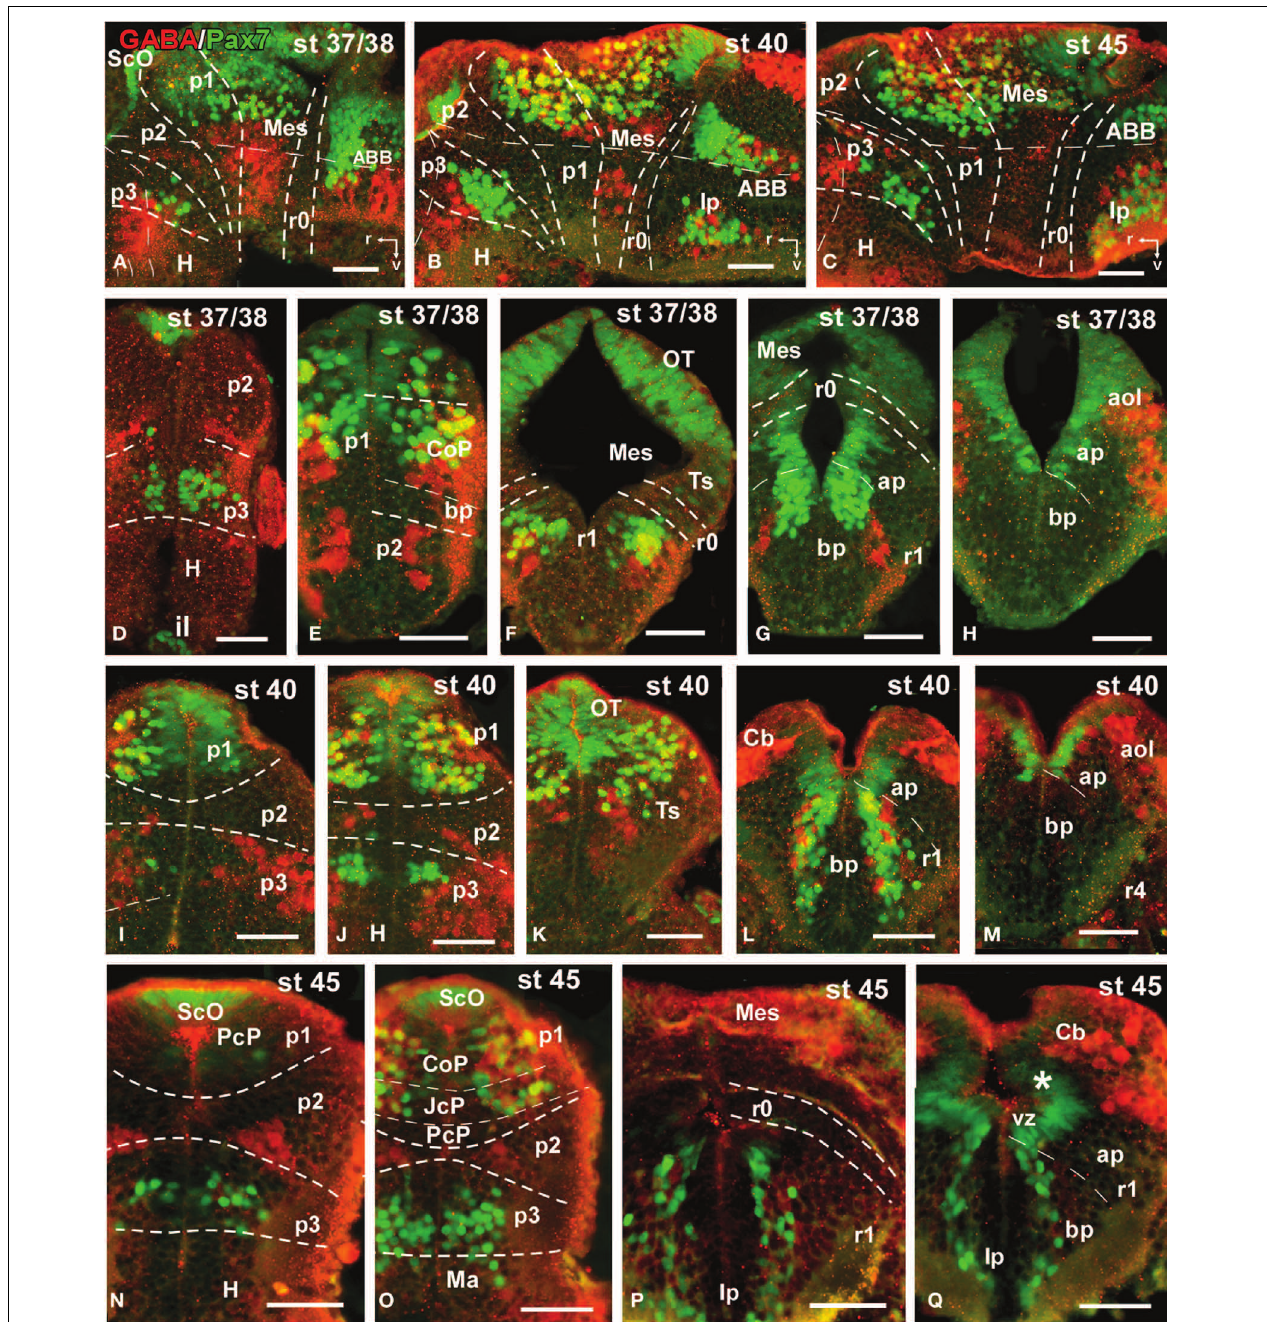
FIGURE 8 | Photomicrographs of double-labeled sagittal (A–C) or transverse (D–Q) sections through the brain of Xenopus laevis showing the localization of Pax7 cells (gree fluorescence) in relationship to GABA (red fluorescence) at different embryonic stages (indicated in the upper right corner of each photomicrograph). All images are oriented following the same